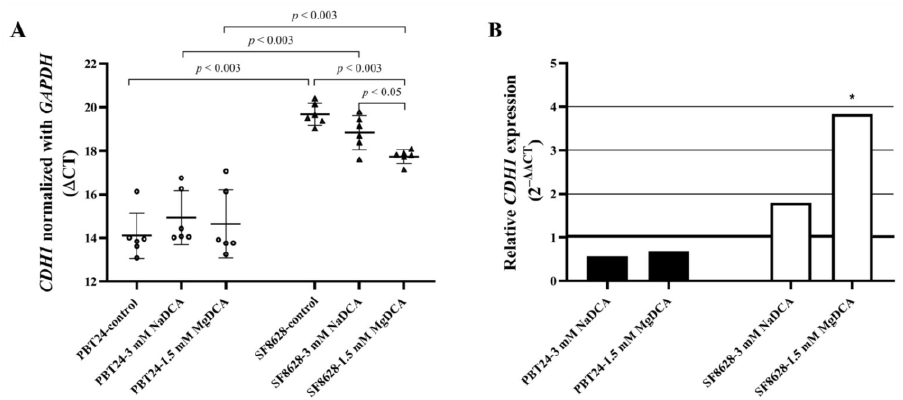
Figure 8. CDH1 expression in PBT24 and SF8628 control and dichloroacetate-treated cell groups. ( A ) The graph shows the ∆ CT value, it’s mean (long horizontal bar), and SD value (short horizontal bars). ( B ) Relative CDH1 expression of PBT24 and SF8628 cell groups treated with dichloroacetate preparations. CDH1 expression of the treated group was compared with the corresponding control. The 1.0 line denotes the reference value of gene expression; * p < 0.05.